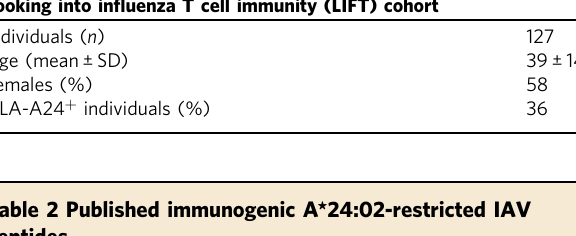
Table 2 Published immunogenic A*24:02-restricted IAV peptides.